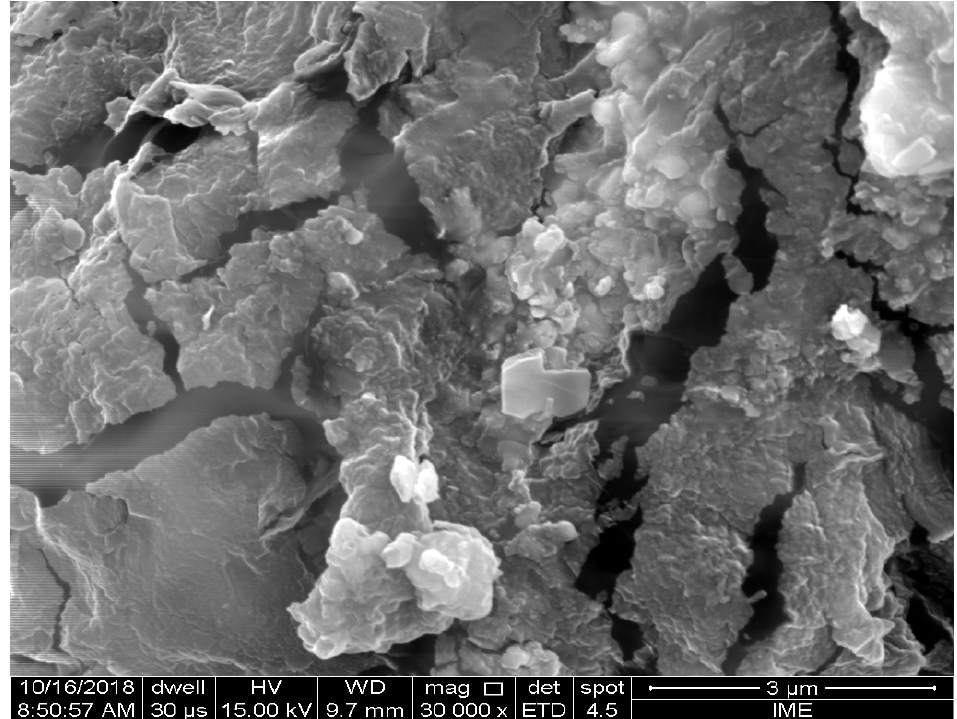
Figure 13. Scanning electron microscopy (SEM) PMMA based dental resins fragments/residues (MAG: 30,000×).